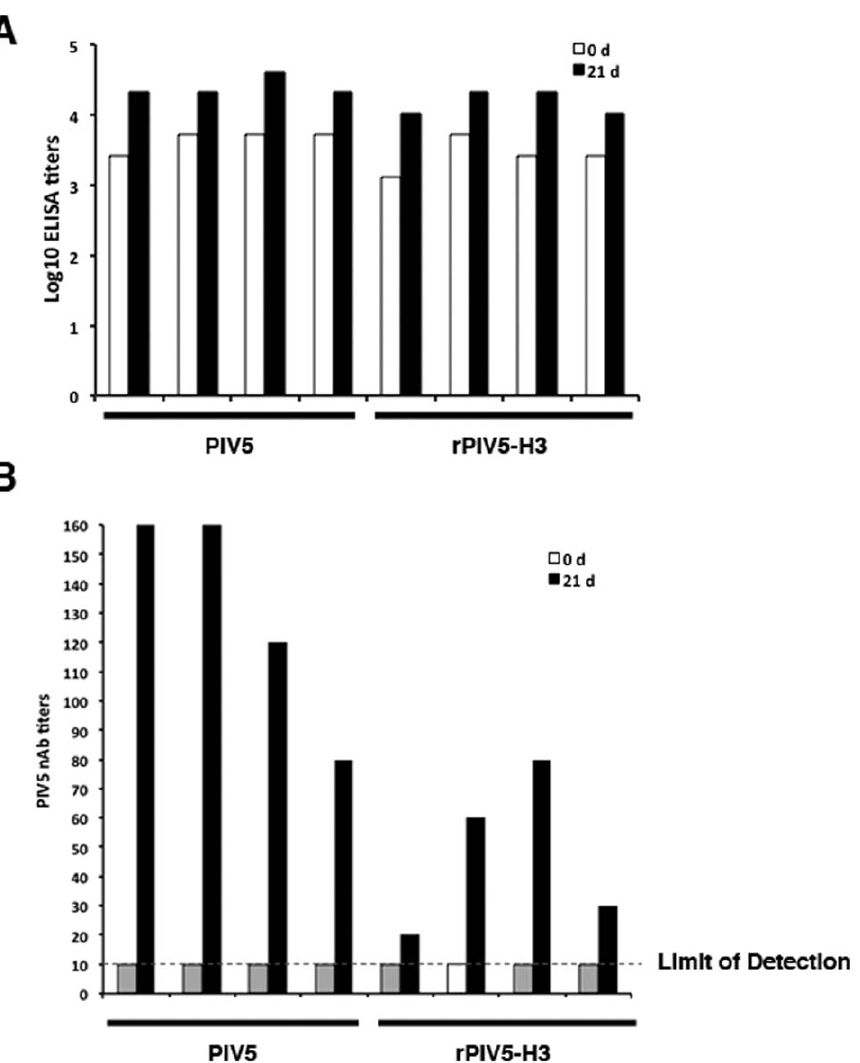
Figure 1. Titers of anti-PIV5 antibodies in dogs without PIV5 exposure. Eight PIV5 naı¨ve dogs were immunized with one dose of 8 6 10 7 PFU of PIV5 or rPIV5-H3 viruses by intranasal route. The dogs were divided into two groups: PIV5-infected dogs and rPIV5-H3-infected dogs. Blood samples were collected at 0 and 21 days post infection for ELISA (A) and virus neutralization antibody (nAb) assay (B). The grey columns indicate that the PIV5 nAb titer is less than 10, the limit of detection in this assay. The black columns indicate that the nAb titer is equal to or higher than